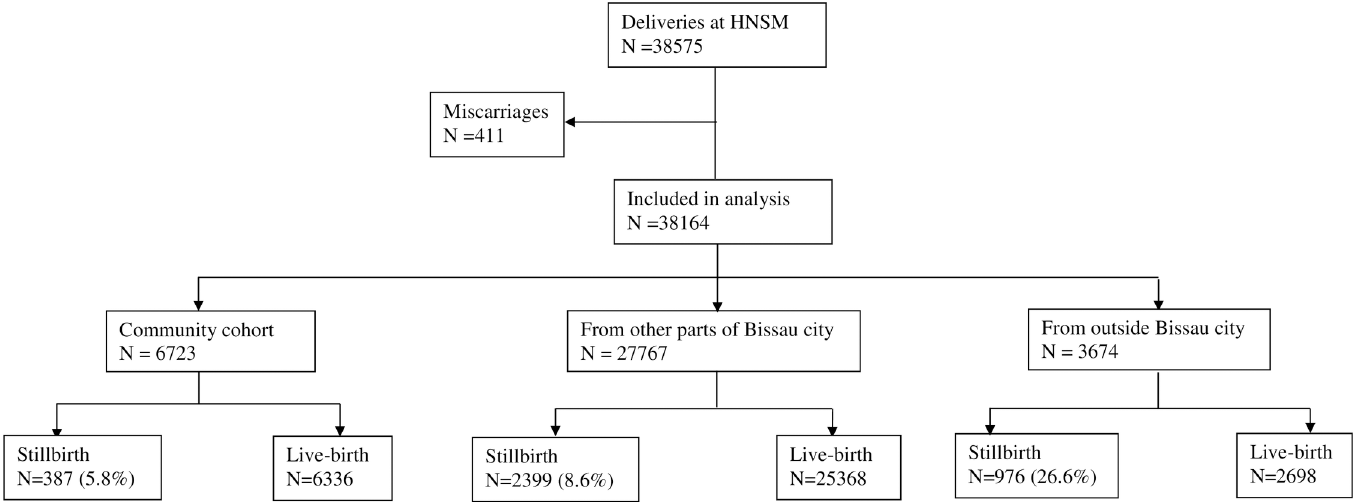
Fig 3. HNSM hospital cohort births from the community cohort (BHP area), rest of Bissau and outside Bissau. The figure illustrates births and stillbirths at the HNSM hospital, including how many were from the community cohort, the rest of the capital Bissau and outside